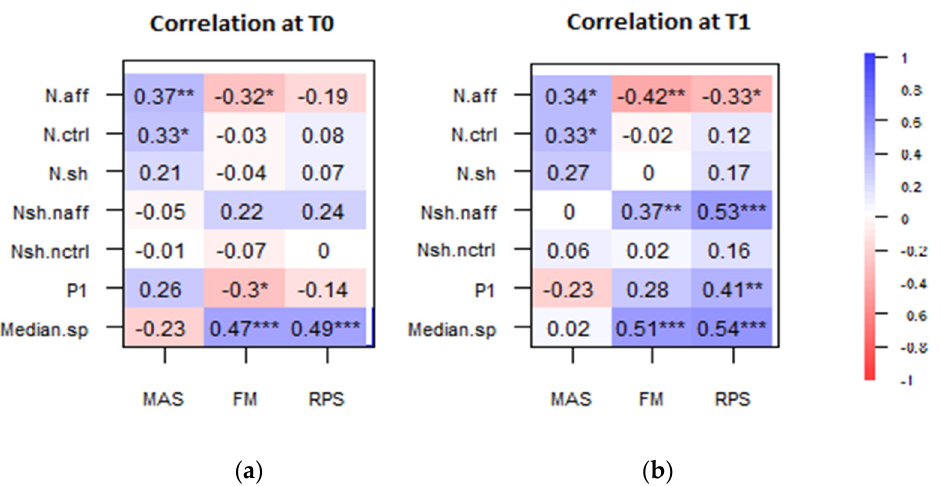
Figure 1. Correlation between clinical outcomes and parameters related to synergies at T0 ( a ) and at T1 ( b ). Significant correlation indices are indicated with * p < 0.05, ** p < 0.01, and *** p < 0.001, respectively. Both the Bartlett’s test of sphericity ( χ 2 = 1396.80, df = 190, p < 0.001) and the